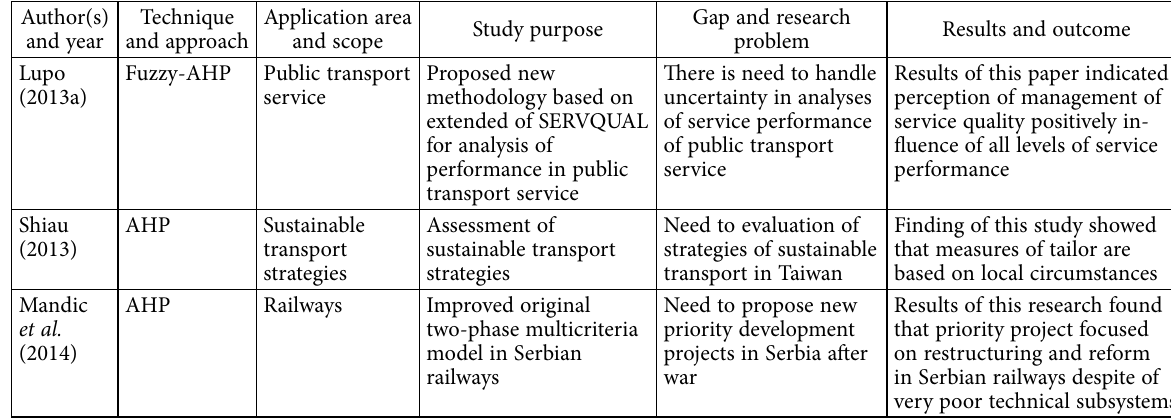
Table 4. Articles based on AHP and